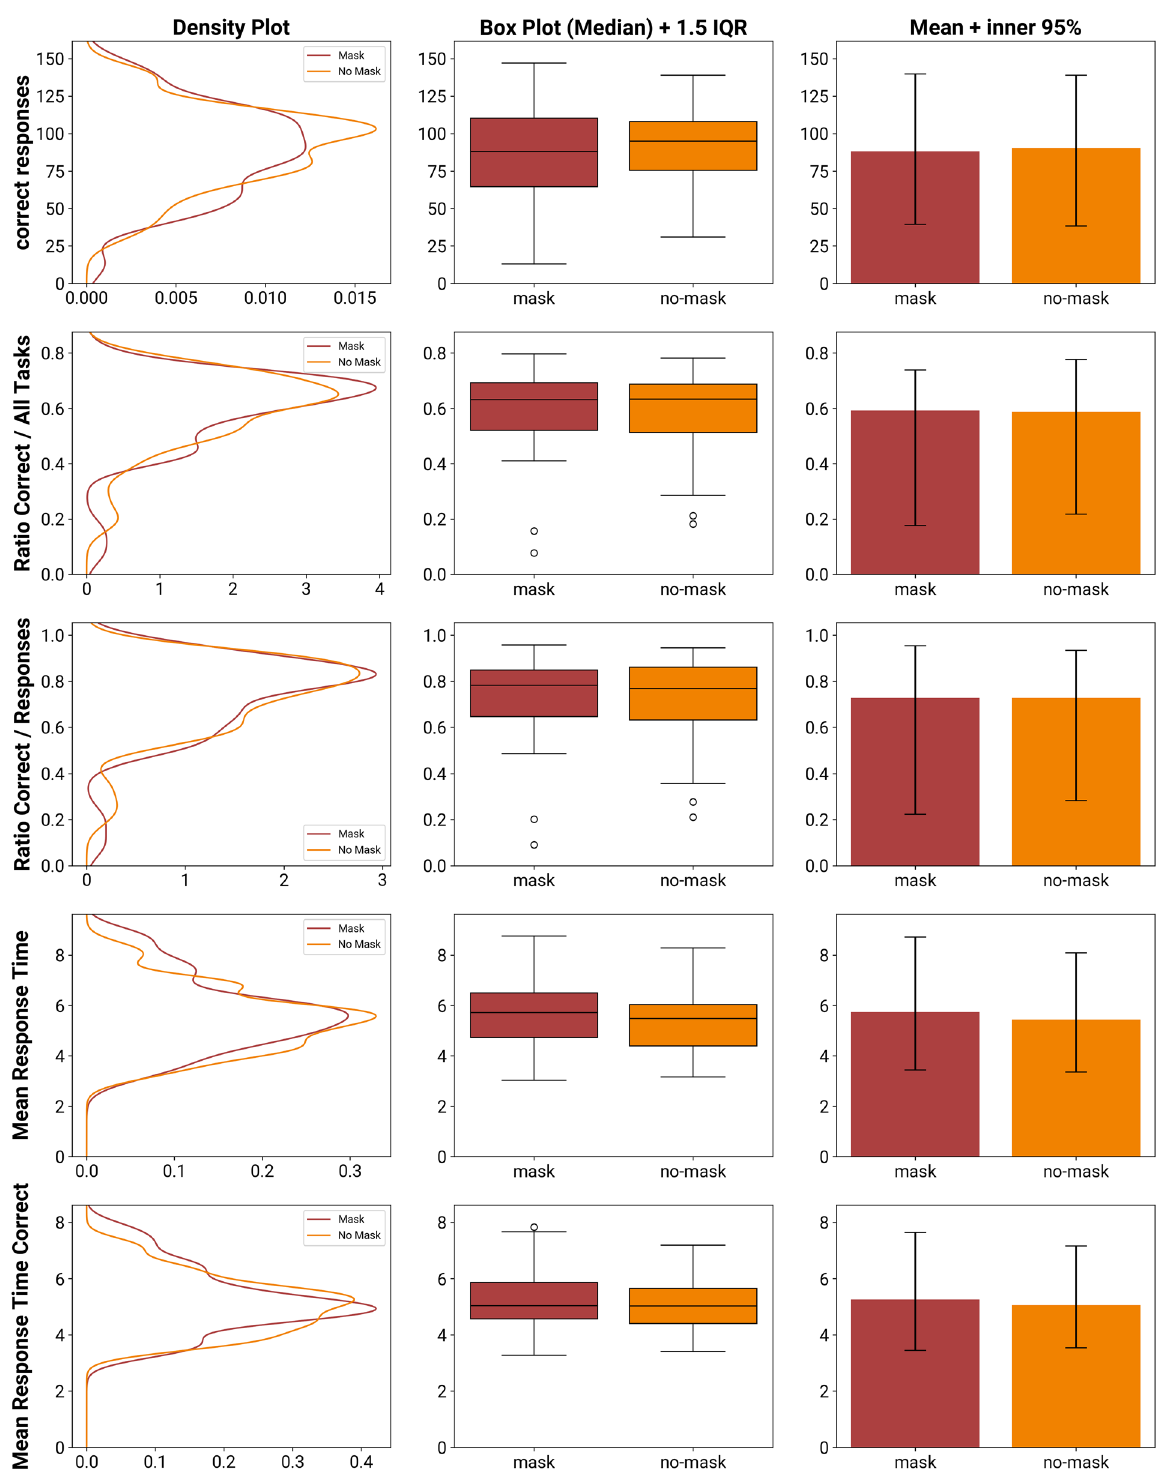
Figure 4. Comparison of the behavioral measures while wearing a mask and not wearing a mask. The dimensions compared are the absolute number of correct responses, the ratios of correct responses against all tasks presented as well as against the number of responses, the mean response time per task, and the mean response time of only the correct